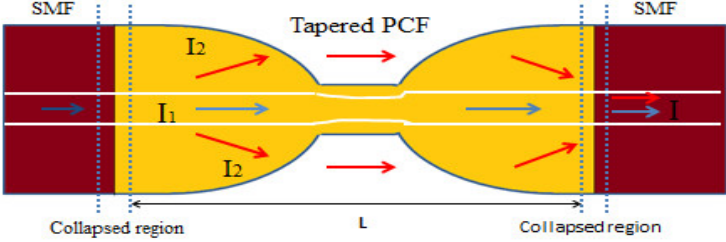
Figure 33. Microscopic image of the ferrofluid infiltrated microstructured polymer optical fiber. It is used for the measurement of magneto-driven optical loss effect of the sensor (Reproduced from [100], with the permission of AIP publishing).